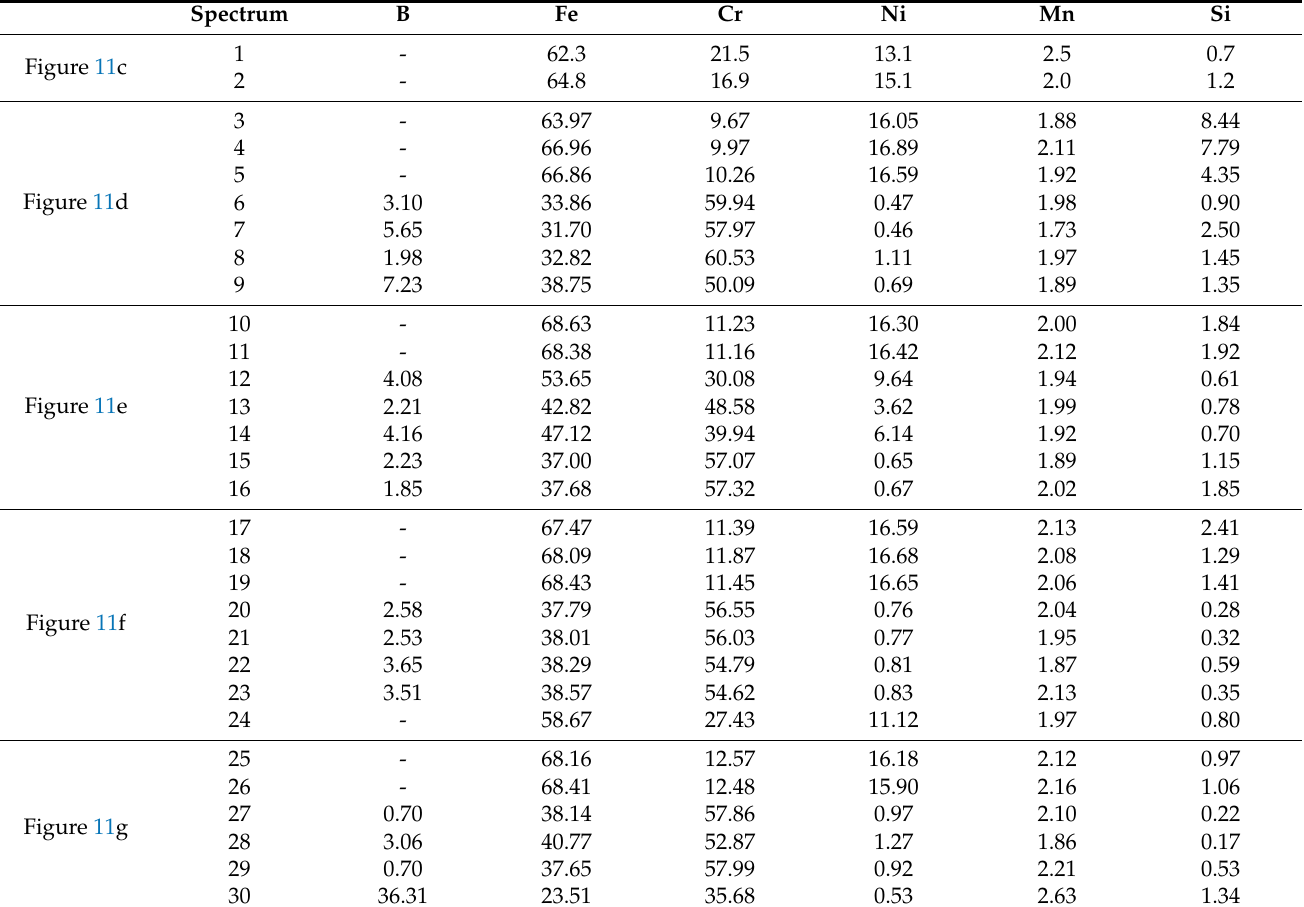
Table 2. Boron and other elements content of SEM (scanning electron microscope) and TEM (trans- mission electron microscope) EDS (energy-dispersive spectroscopic) points of BSS (borated stainless steel)